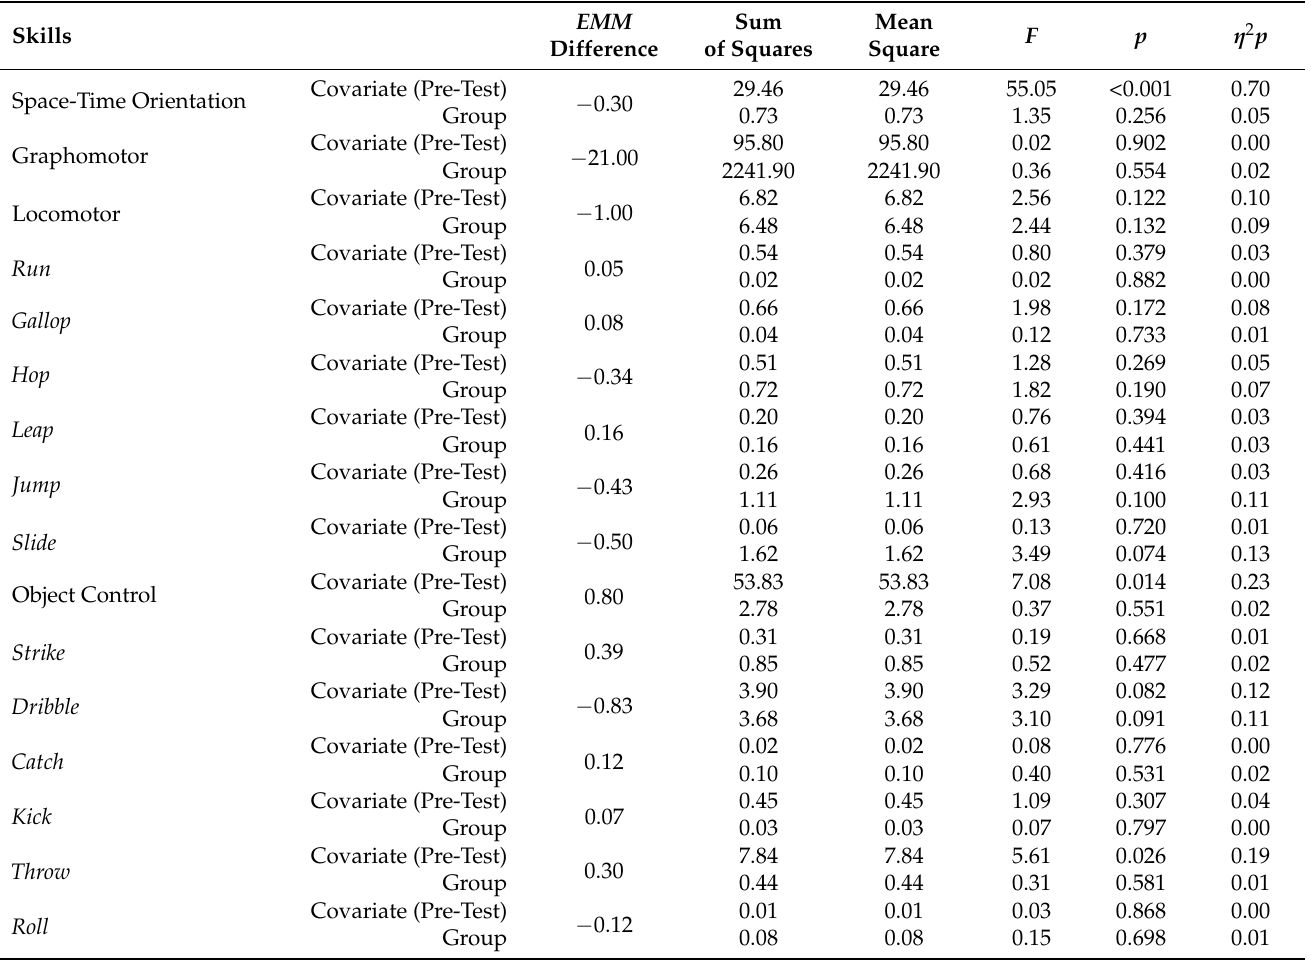
Table 3. The estimated difference in post-test scores between the control and experimental group and the analysis of covariance ( ANCOVA ) results (the result of the pre-test was set as the